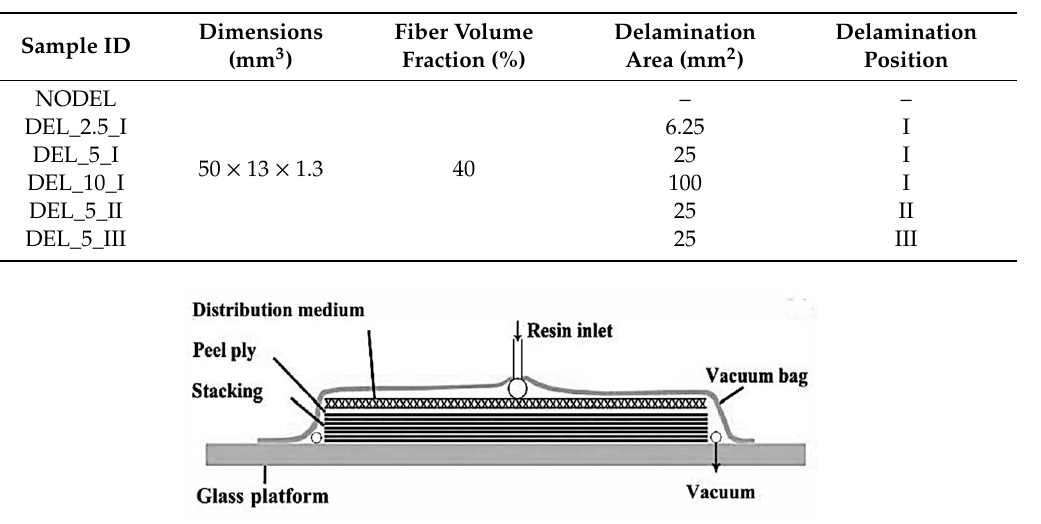
Table 1. Summary of delamination properties for different samples.